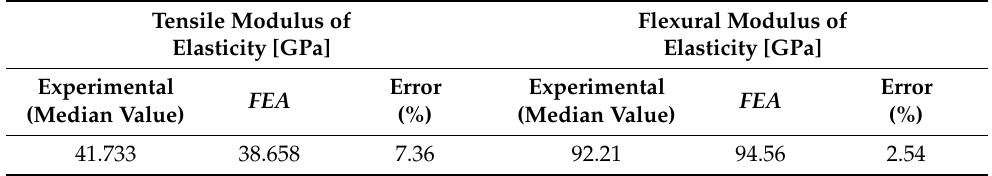
Table 5. Comparison between the experimental and FEA analysis results for the tensile and bending